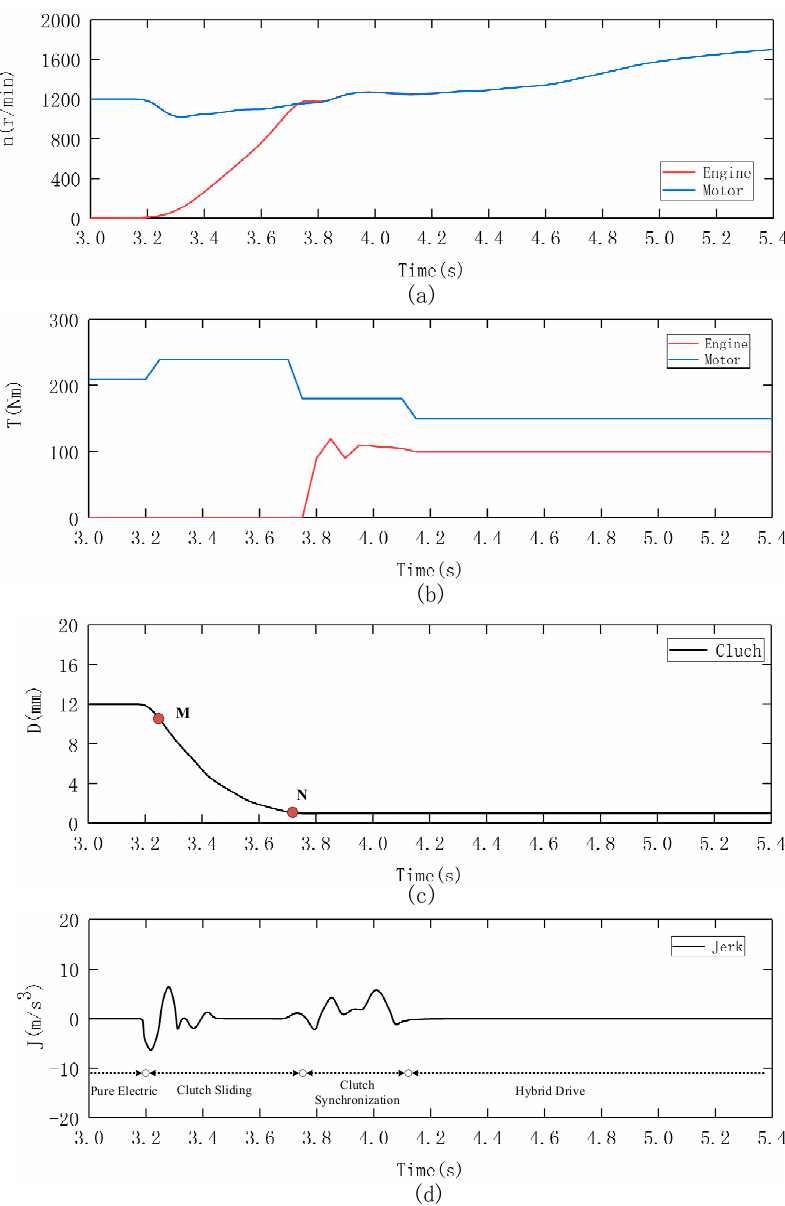
Figure 7. Simulation results of mode transition with the proposed control strategy. ( a ) speeds of the engine and motor; ( b ) torques of the engine and motor; ( c ) displacement of the clutch ( d ) jerk of the driveline.